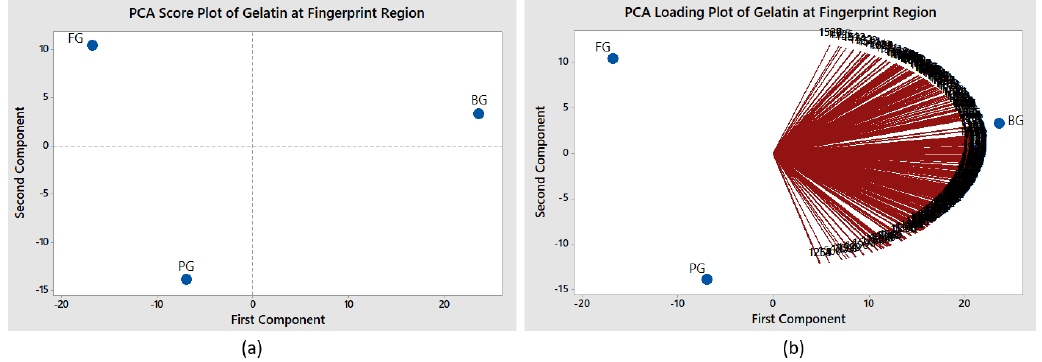
Figure 5. PCA ( a ) score and loading plots ( b ) for gelatins at fingerprint region. Table 3. Comparison of c-FACS and PCA performances. c-FACS PCA 7.86 s 12.86